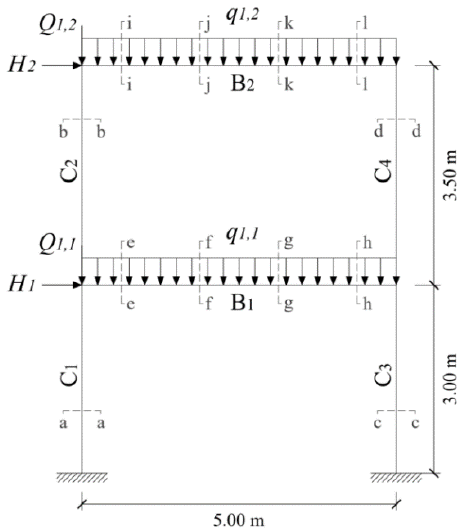
Figure 5. Plane frame - Example